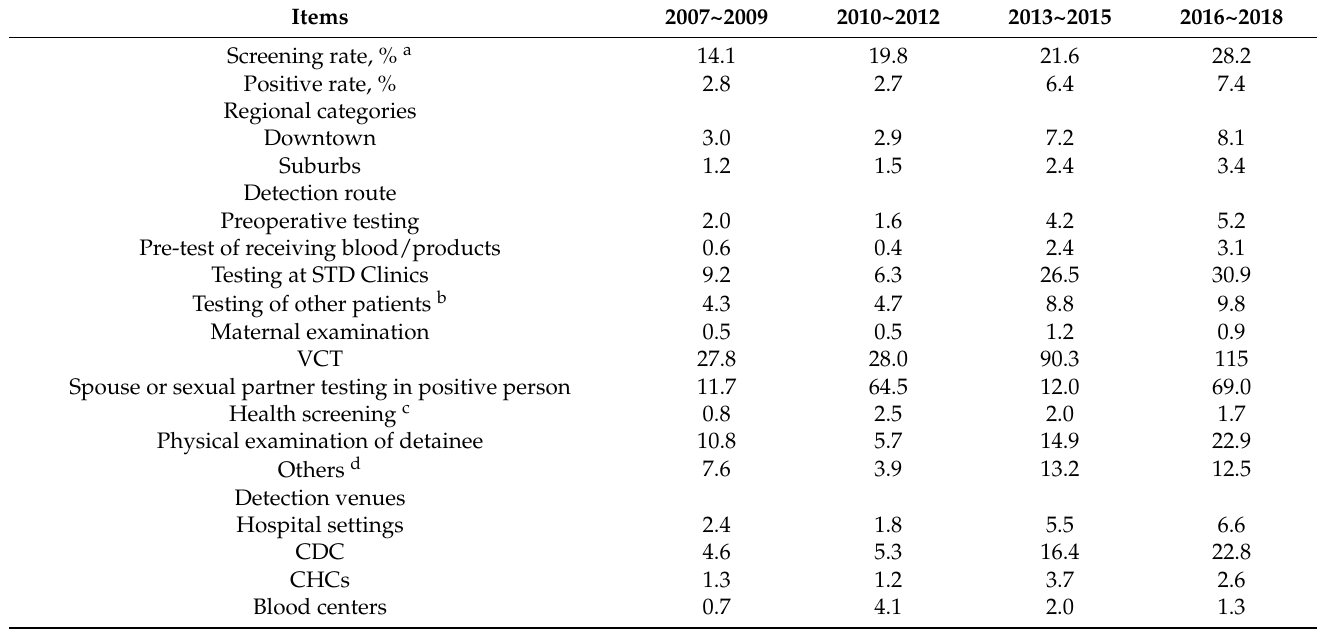
Table 1. HIV screening and diagnosis rate in Hangzhou,